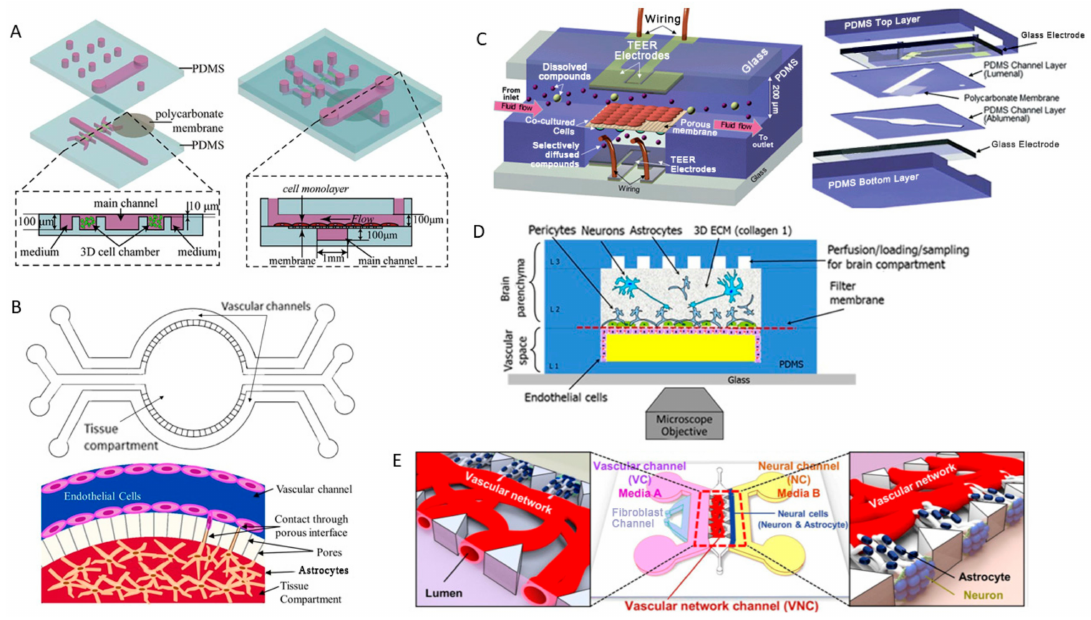
Figure 3. Schematic diagrams of blood-brain barrier (BBB)-on-chip models. ( A ) microchip BBB model [161]; ( B ) Neonatal BBB-on-chip [163]; ( C ) µ BBB system [164]; ( D ) Neurovascular microfluidic bioreactor [165]; ( E ) 3D microfluidic neurovascular unit platform